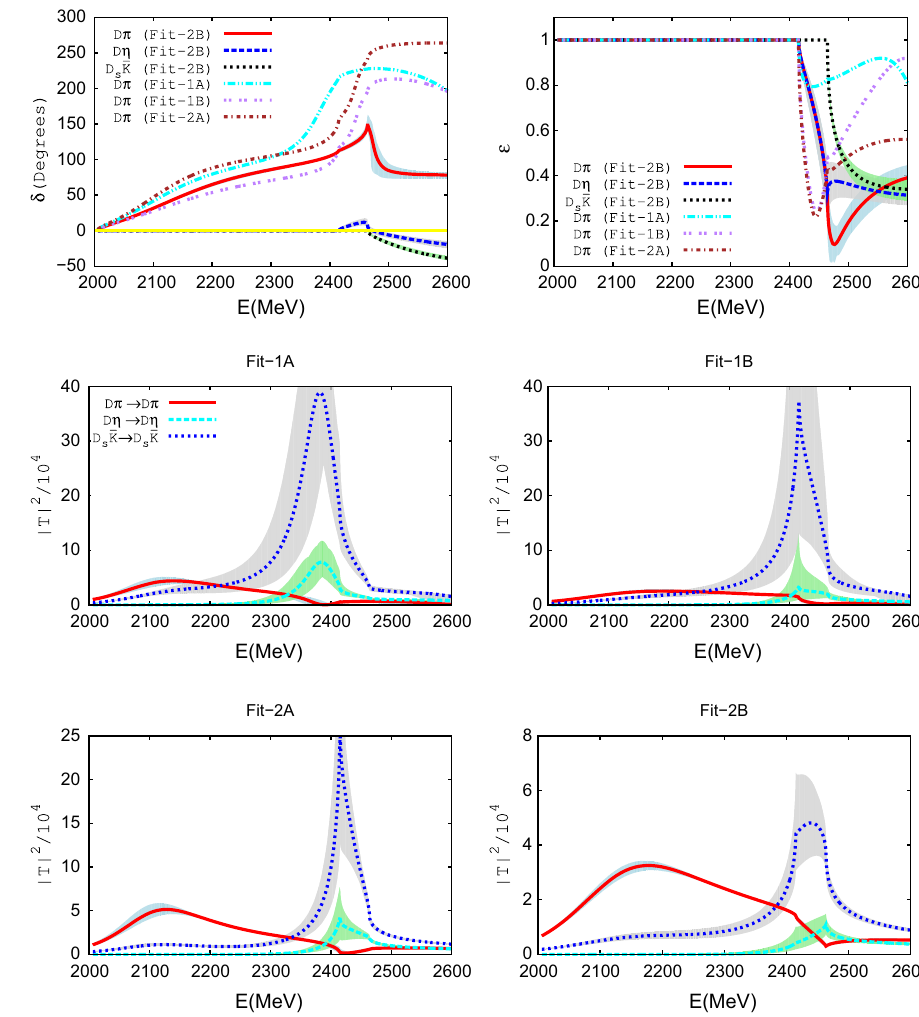
Fig. 6 Phase shifts ( δ ) and inelasticities ( ε ) of the coupled-channel D π, D η and D s ¯ K S -wave scattering with ( S , I ) = ( 0 , 1 / 2 ) obtained at physical meson masses. For notaion, see Fig. 5